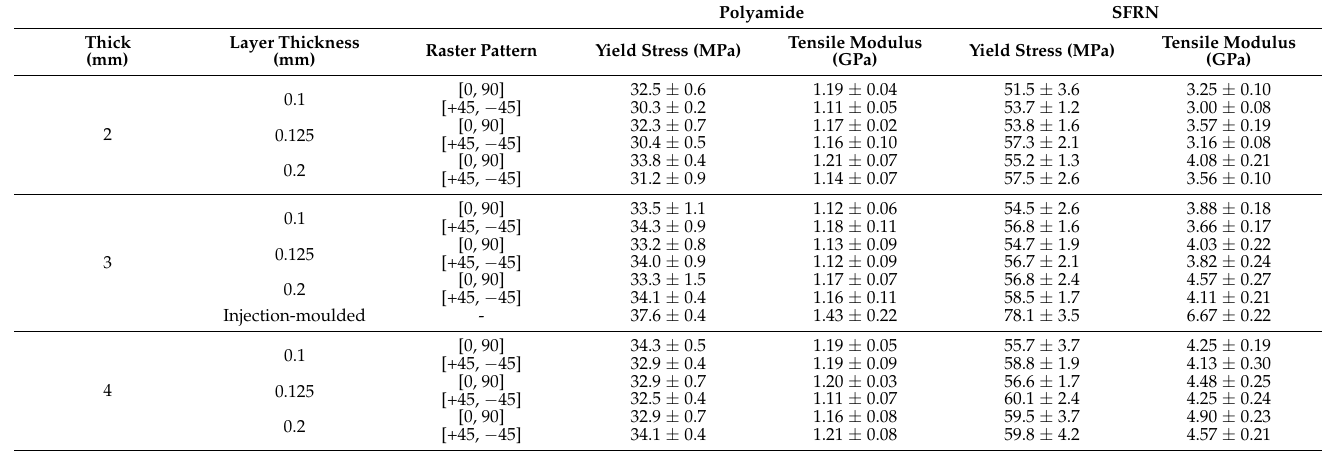
Table 4. The tensile properties of the printed and injection-moulded samples.